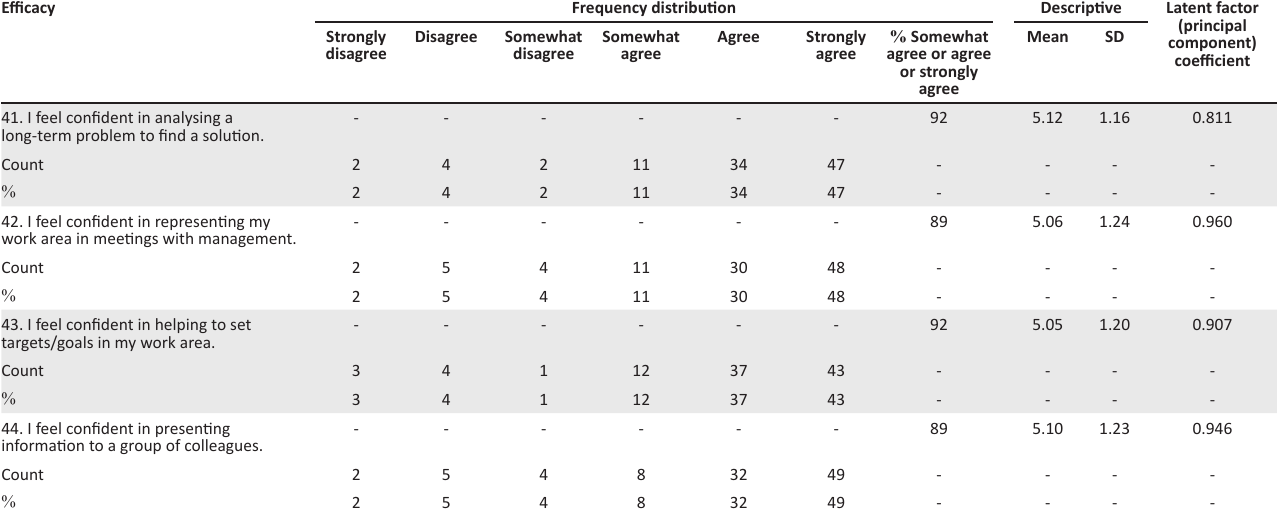
TABLE 12: Analysis of the construct of efficacy. Efficacy